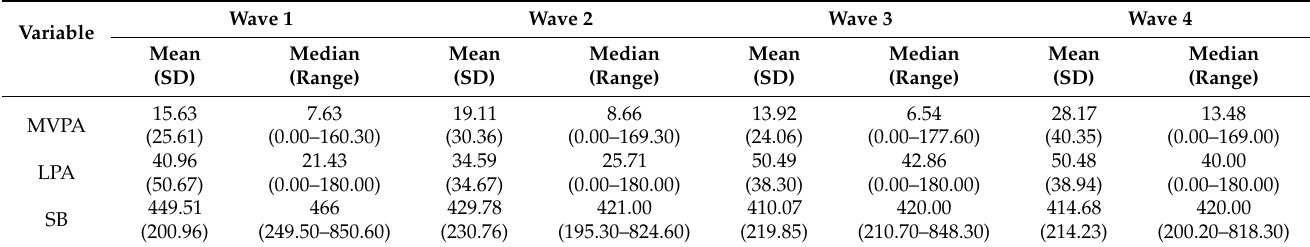
Table 2. Descriptive characteristics of physical activity and sedentary behavior in different waves.